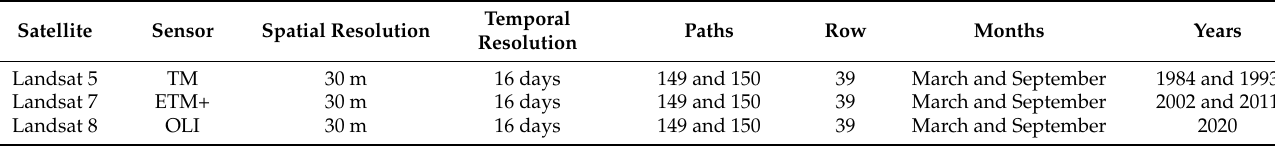
Table 1. Specification of Landsat satellite images.